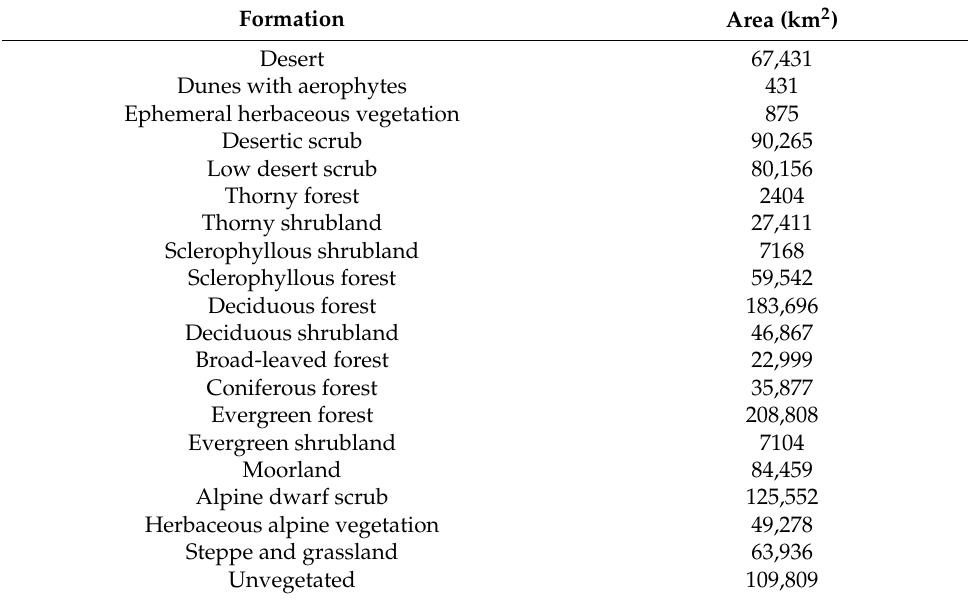
Table 2. Vegetational formations used for